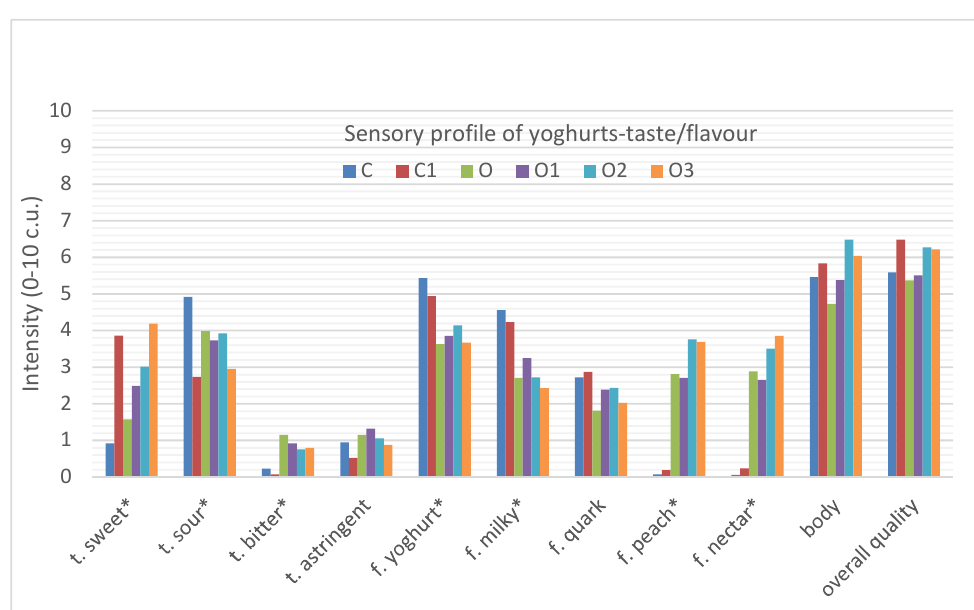
Figure 4. Sensory quality profile of yoghurts describing the taste (t) and flavour (f) attributes as well as body and overall quality. C, control; C1, control with 6% inulin; O, oolong tea; O1, oolong tea with 3% inulin; O2, oolong tea with 6% inulin; O3, oolong tea with 9% inulin (* p ≤ 0.05 differ significantly).